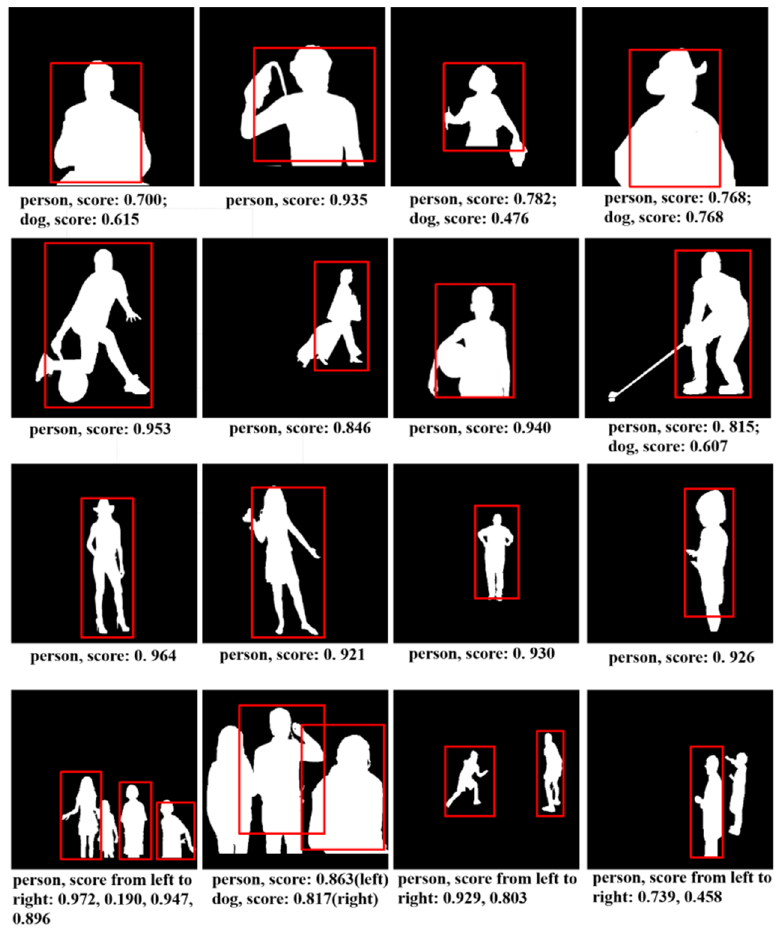
Figure 3. The 16 representative person contour shape maps were selected from the test set with their confidence and predicted bounding boxes.